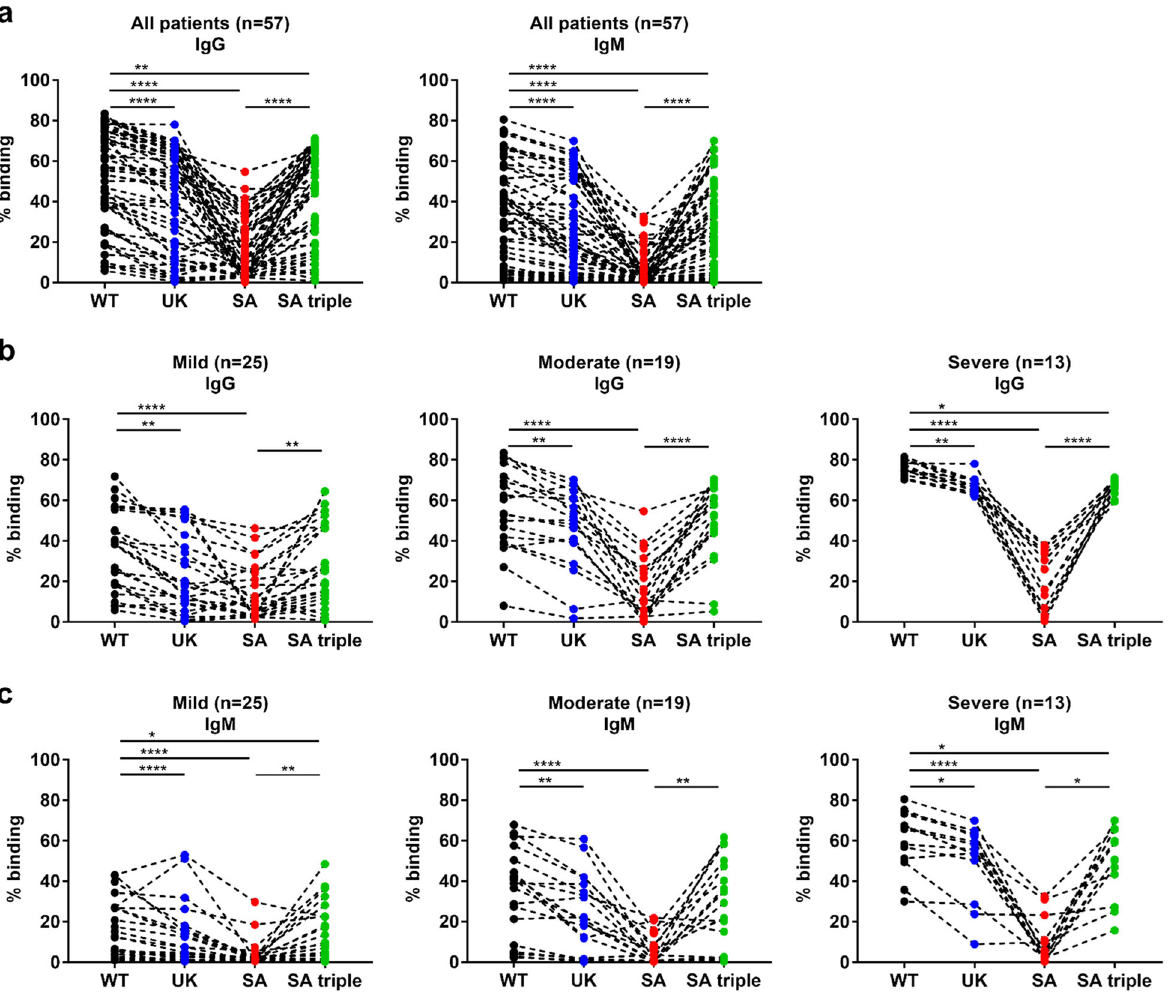
Fig. 1 S protein-speci fi c antibody pro fi le against WT, UK, SA and RBD-speci fi c SA triple variants. Plasma samples were collected from COVID-19 patients with SARS-CoV-2 infections ( n = 57) at median 31 days post-illness onset (pio) (mild, n = 25; moderate, n = 19;